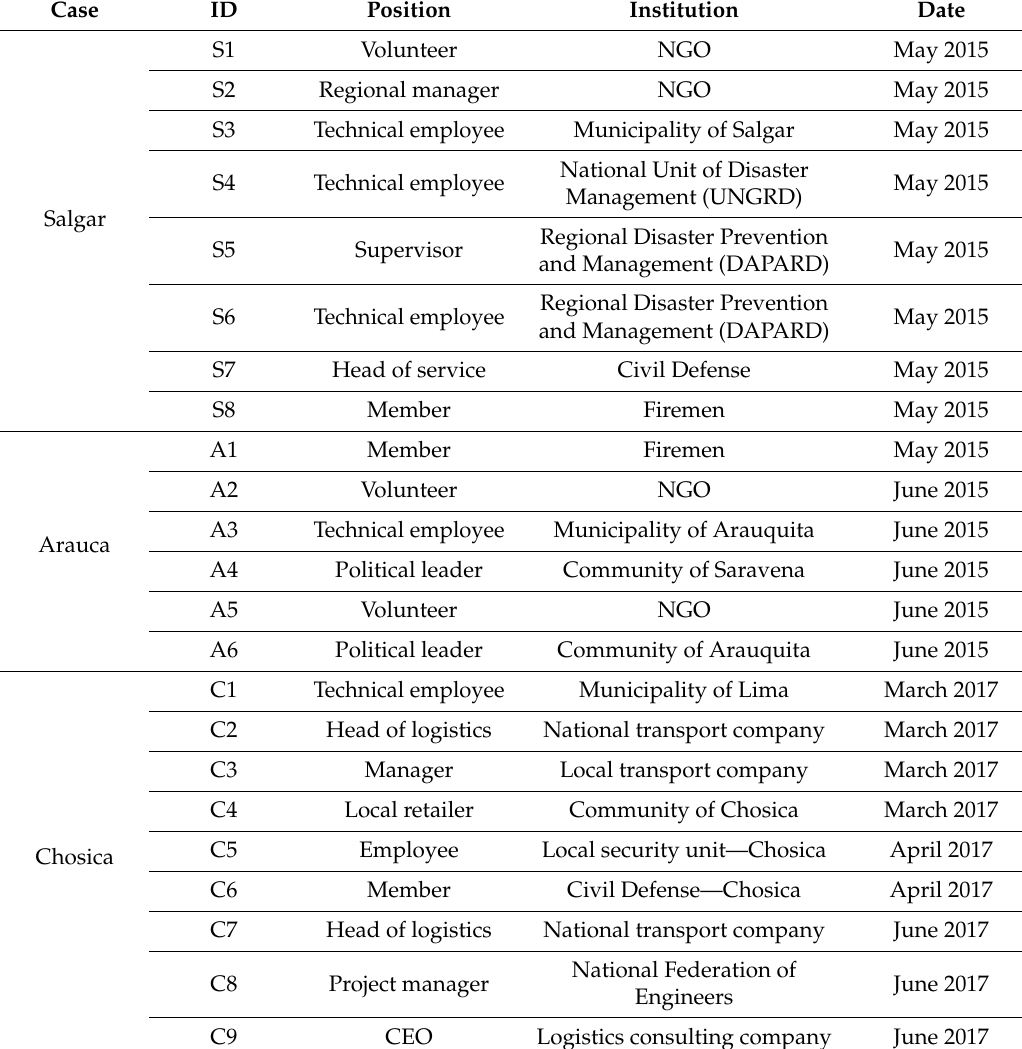
Table 2. Details of interviews for the retained three